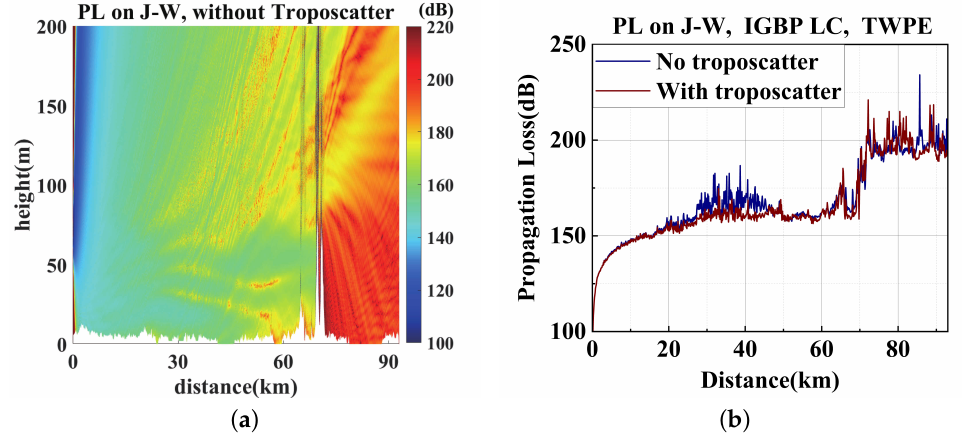
Figure 15. The PL on Jiaxing–Wuxi ( a ) in space ( b ) at a height of 60 m. ( a ) PL on Jiaxing–Wuxi without the troposcatter. ( b ) PL on J–W at a height of 60 m with or without the troposcatter.